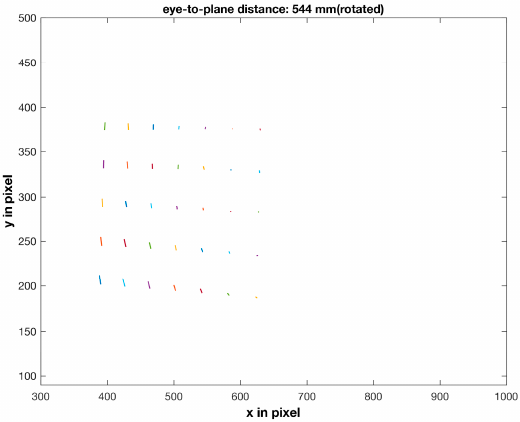
Figure A7. Map of disparities for a target plane rotated and placed at 544 mm from the observer.